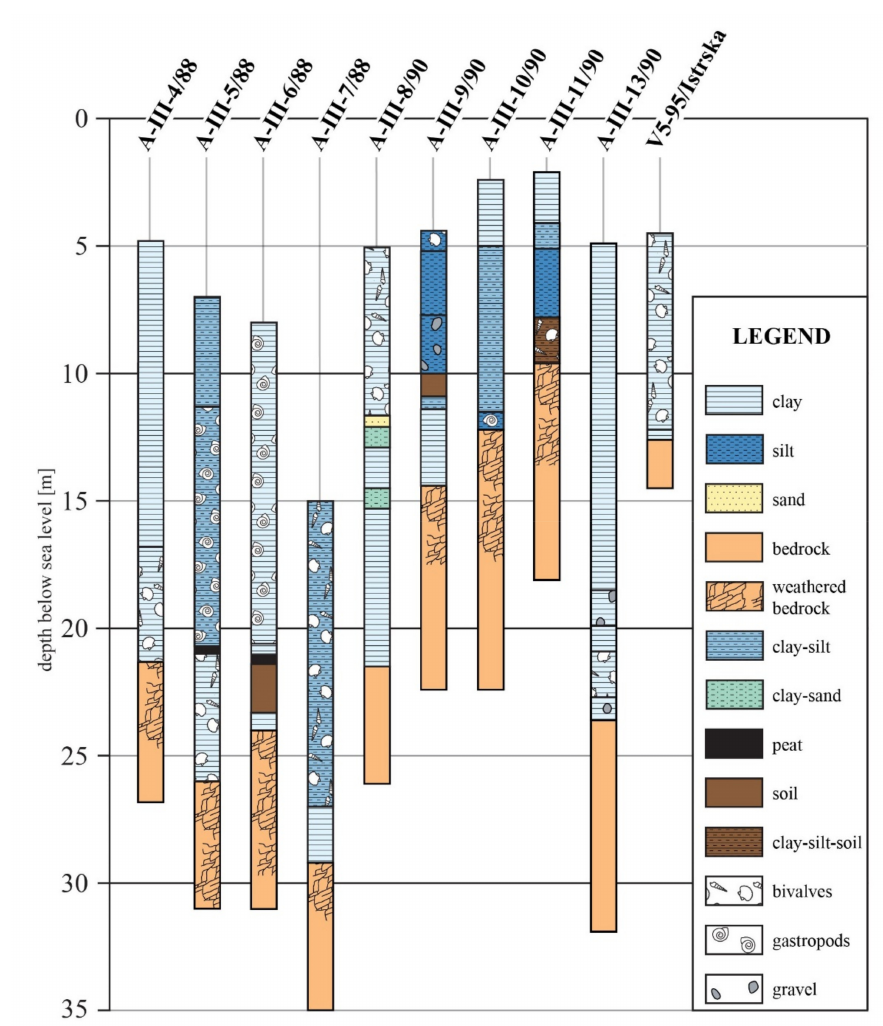
Figure 3. Sub-bottom sonar profiles (with superimposed boreholes) where the top of the Eocene bedrock is expressed as a single undulating medium-to-high amplitude reflection (( a ), ( b ) and ( c )). For profile locations, see Figure 2. Blue overlay marks the Quaternary sediment and orange overlay marks the bedrock. Peat layers are indicated with brown arrows. Red overlay within the Quaternary section marks isolated di ff raction hyperbolas. Red overlay in the water column marks reflection events above the seafloor. Green overlay marks the extent of seagrass meadows on the seafloor. Dredged areas are marked with grey arrows. Multiples are indicated by thin black